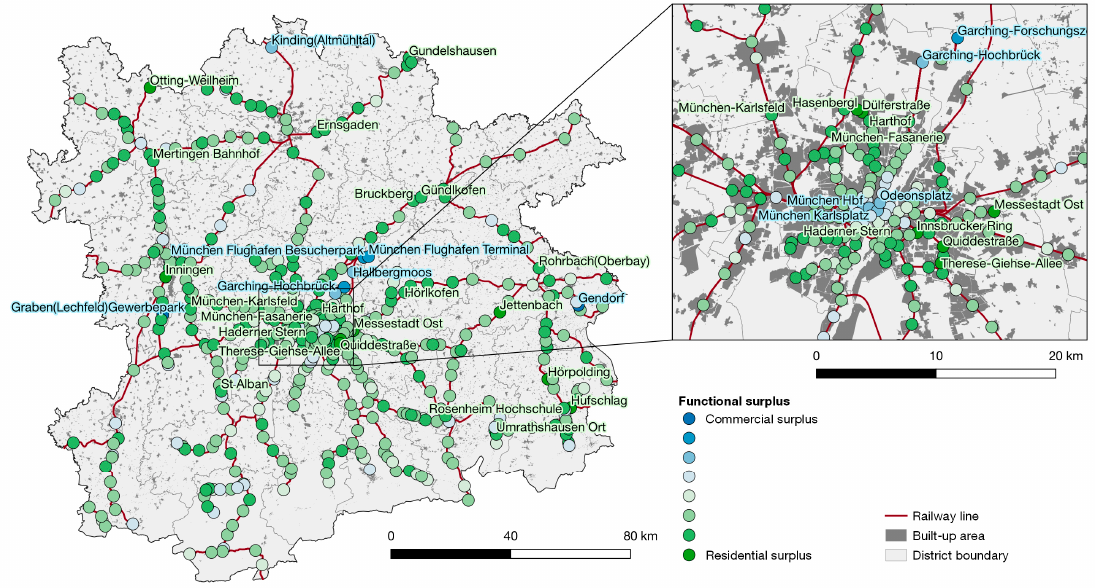
Figure 8. Surplus of residential or commercial (firms and services) uses at railway stations in the MMR 2019 (Source: own work, using geodata by Bayerische Vermessungsverwaltung, Bundesamt für Kartographie und Geodäsie, Deutsche Bahn).